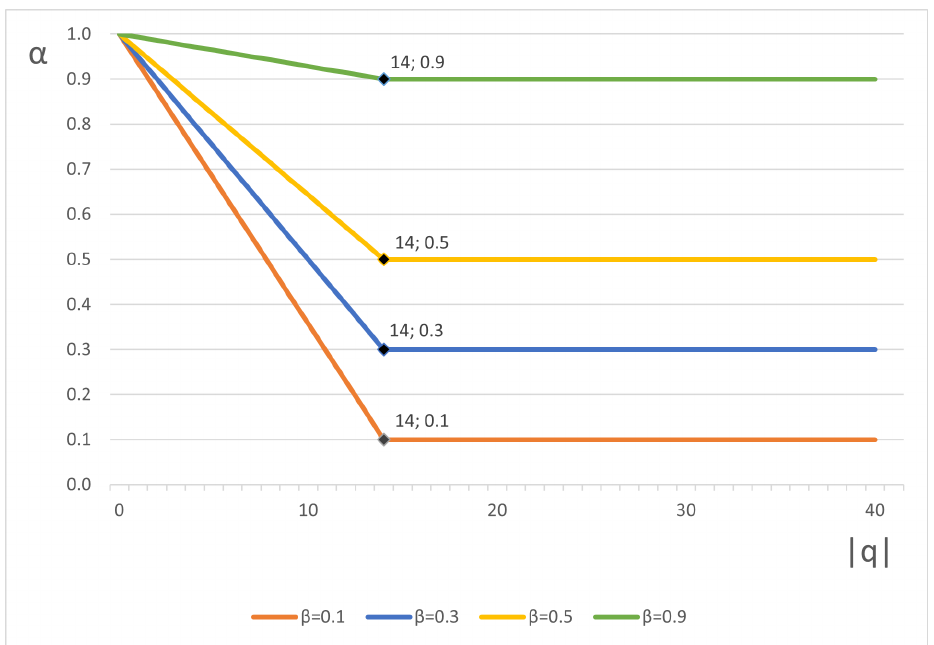
Figure 3. Mixture parameter α as a function of query verbosity q , β controlling minimum CBR